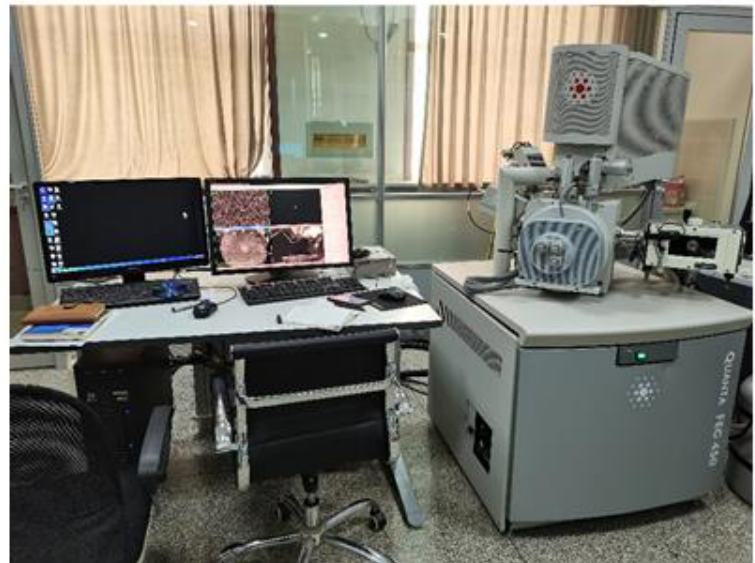
Figure 7. SEM Figure 7. SEM equipment.